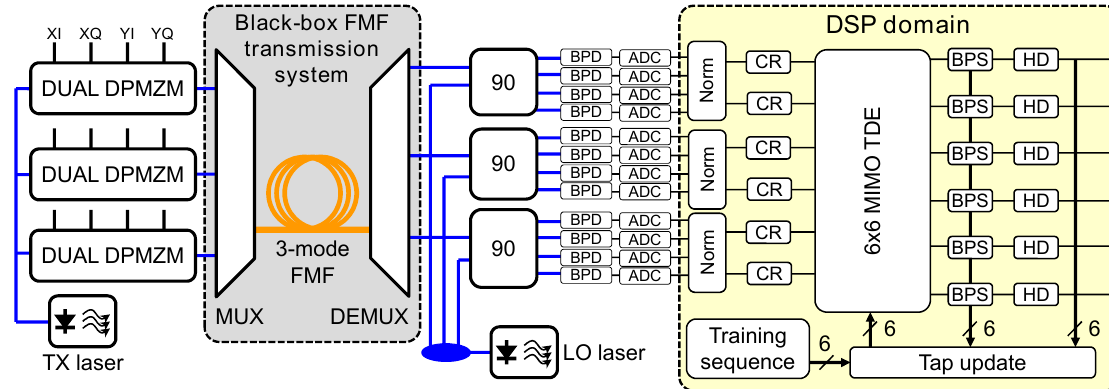
Figure 1. Schematic diagram of a typical optical transmission system consisting of a few-mode fiber supporting 6 spatial channels (2 mode-groups and 6 orthogonal modes). X polarization in-phase component (XI), X polarization quadrature component (XQ), Y polarization in-phase component (YI), Y polarization quadrature component (YQ), dual-parallel Mach-Zehnder modulator (DPMZM), transmitter (TX), multiplexer (MUX), demultiplexer (DEMUX), balanced photodiode (BPD), analog to digital converted (ADC), local oscillator (LO), digital signal processing (DSP), normalization (NORM), clock recovery (CR), multiple-input multiple-output (MIMO), time-domain equalizer (TDE), blind phase search (BPS), hard-detection